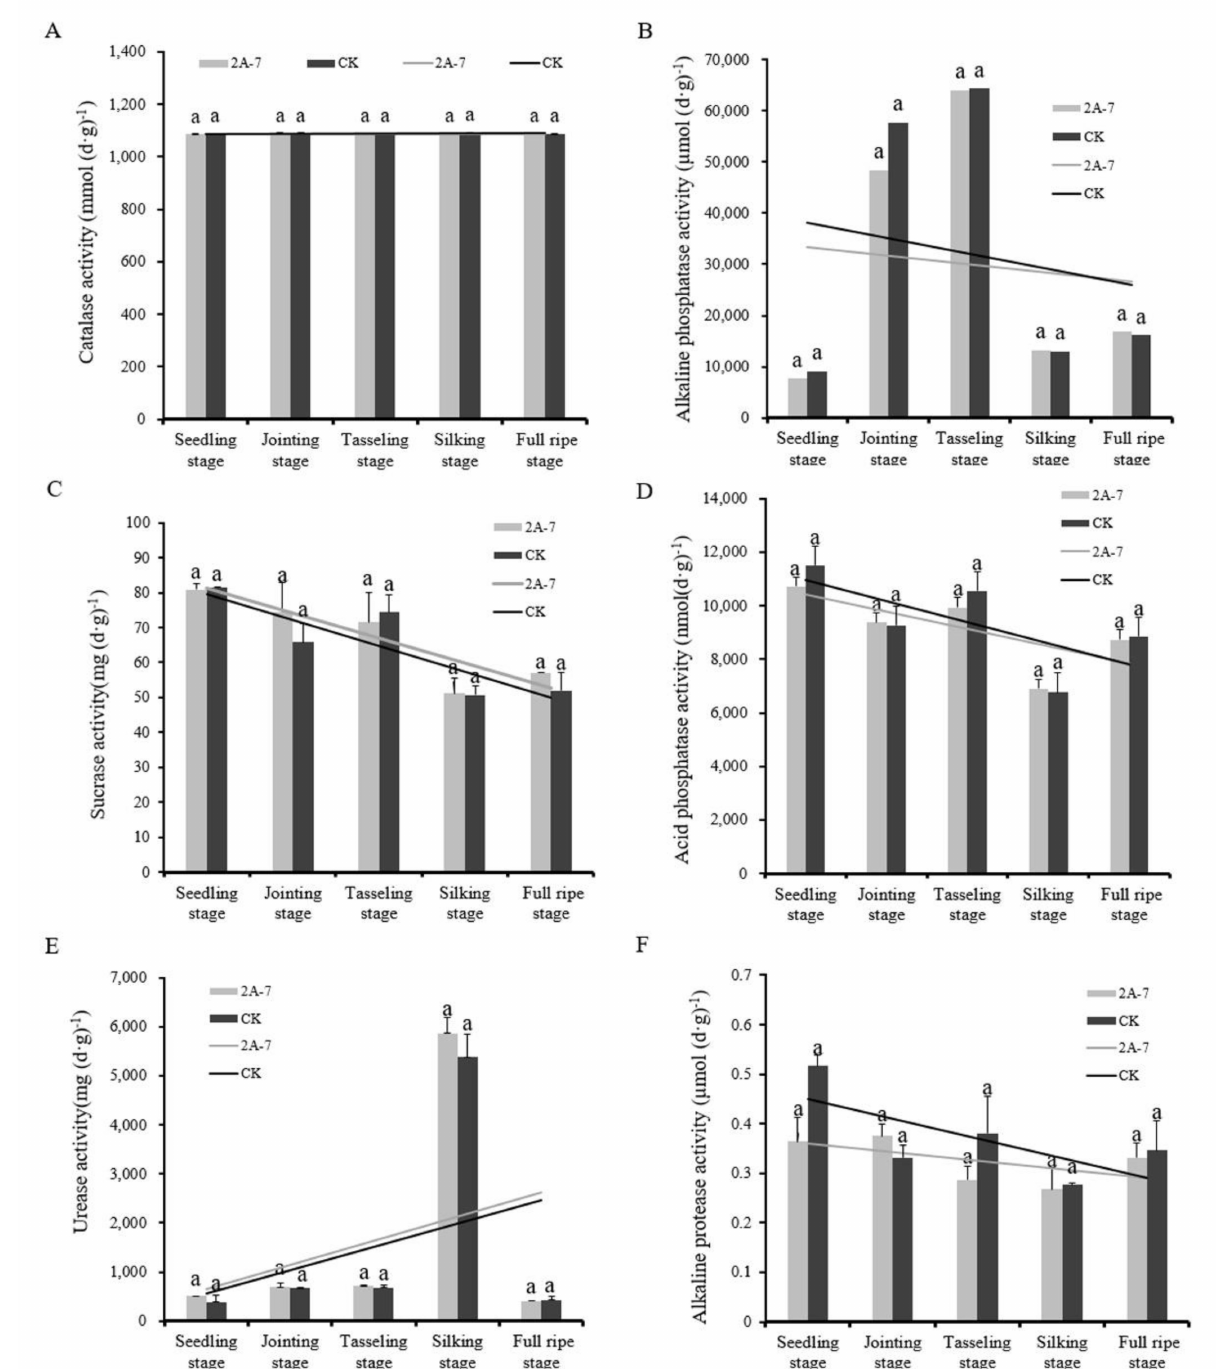
Figure 1. Effects of transgenic maize 2A-7 on the enzyme activities in the rhizosphere soil at different developmental stages. ( A ) Catalase activity; ( B ) alkaline phosphatase activity; ( C ) sucrase activity; ( D ) acid protease activity; ( E ) urease activity; ( F ) alkaline protease activity. 2A-7 represents the transgenic maize 2A-7, and CK represents the non-transgenic control Dongdan 6531. Letters above the columns indicate significant differences in rhizosphere soil treatments between the two maize lines at the same developmental stage ( p < 0.05). The linear trend lines were graphed for the two maize cultivars at the five developmental